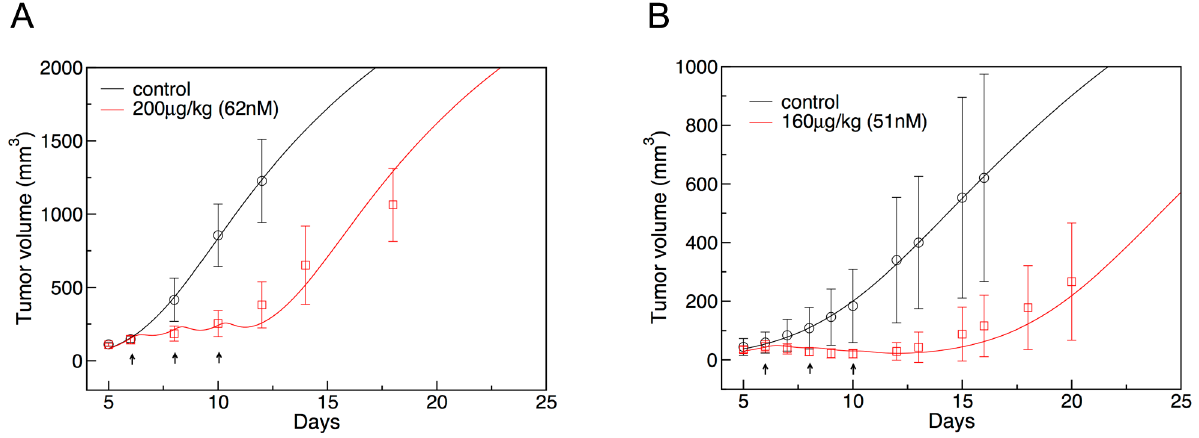
Figure 3. Measured (symbols with error bars) and computed (line) tumor volumes with time of A431/H9 (A) and ATAC-4 (B) cell tumors growing in nude mice. The experimental data are from Zhang et al. [7] and Singh et al. [15]. In each panel, the black line and symbols are for control with no immunotoxin and the red line and symbols are for the case when immunotoxin was given three times, at times indicated by the black arrows. The dose level was 200 m g/kg (62 nM) for SS1P (panel A) and 160 m g/kg (51 nM) for LMB-2 (panel B).